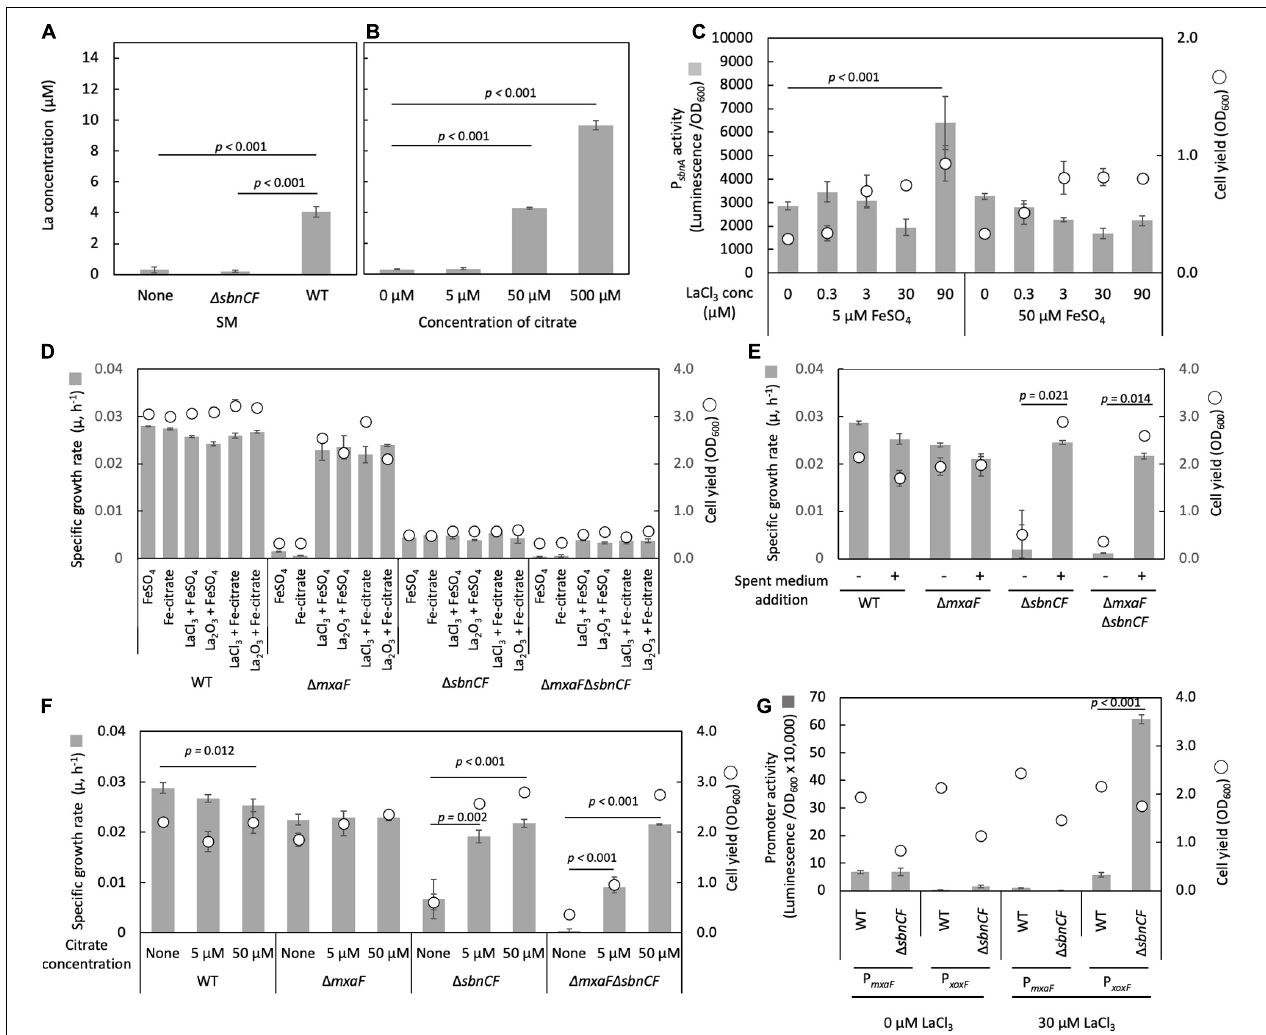
FIGURE 4 | (A) Solubilization of La 2 O 3 by the spent media (SM) of the wild-type strain 22A (WT) and (cid:49) sbnCF , and non-inoculated medium control. (B) Solubilization of La 2 O 3 by citrate (5–500 µ M). (C) P sbnA activity in (cid:49) mxaF in the presence of varied concentrations of LaCl 3 under 5 and 50 µ M FeSO 4 . (D) Growth of the WT, (cid:49) mxaF , (cid:49) sbnCF , and (cid:49) mxaF (cid:49) sbnCF on methanol in the presence of 100 µ M FeSO 4 , 100 µ M iron citrate, 9 mg/l La 2 O 3 , and 30 µ M LaCl 3 , and their mixtures. (E) Growth of the same set of mutants on methanol in the presence/absence of the spent medium of the WT, under 100 µ M FeSO 4 and 30 µ M LaCl 3 . (F) Growth of the same set of mutants on methanol in the presence of different concentrations of citrate, under 50 µ M FeSO 4 and 30 µ M LaCl 3 . (G) P mxaF and P xoxF activity in WT and (cid:49) sbnCF grown on methanol plus succinate in the absence/presence of 30 µ M LaCl 3 . All data represent the mean of three replicates ± standard deviation